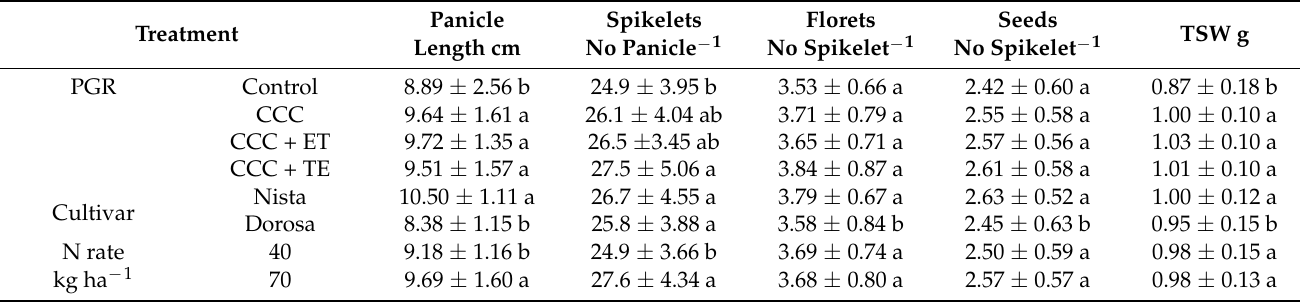
Table 9. Panicle characteristics (panicle length, number of spikelets, number of florets and number of seeds per spikelet) and 1000-seed weight of red fescue ( Festuca rubra ssp. rubra cv. Nista and F . r . ssp. commutata cv. Dorosa), means for two production years, and two field